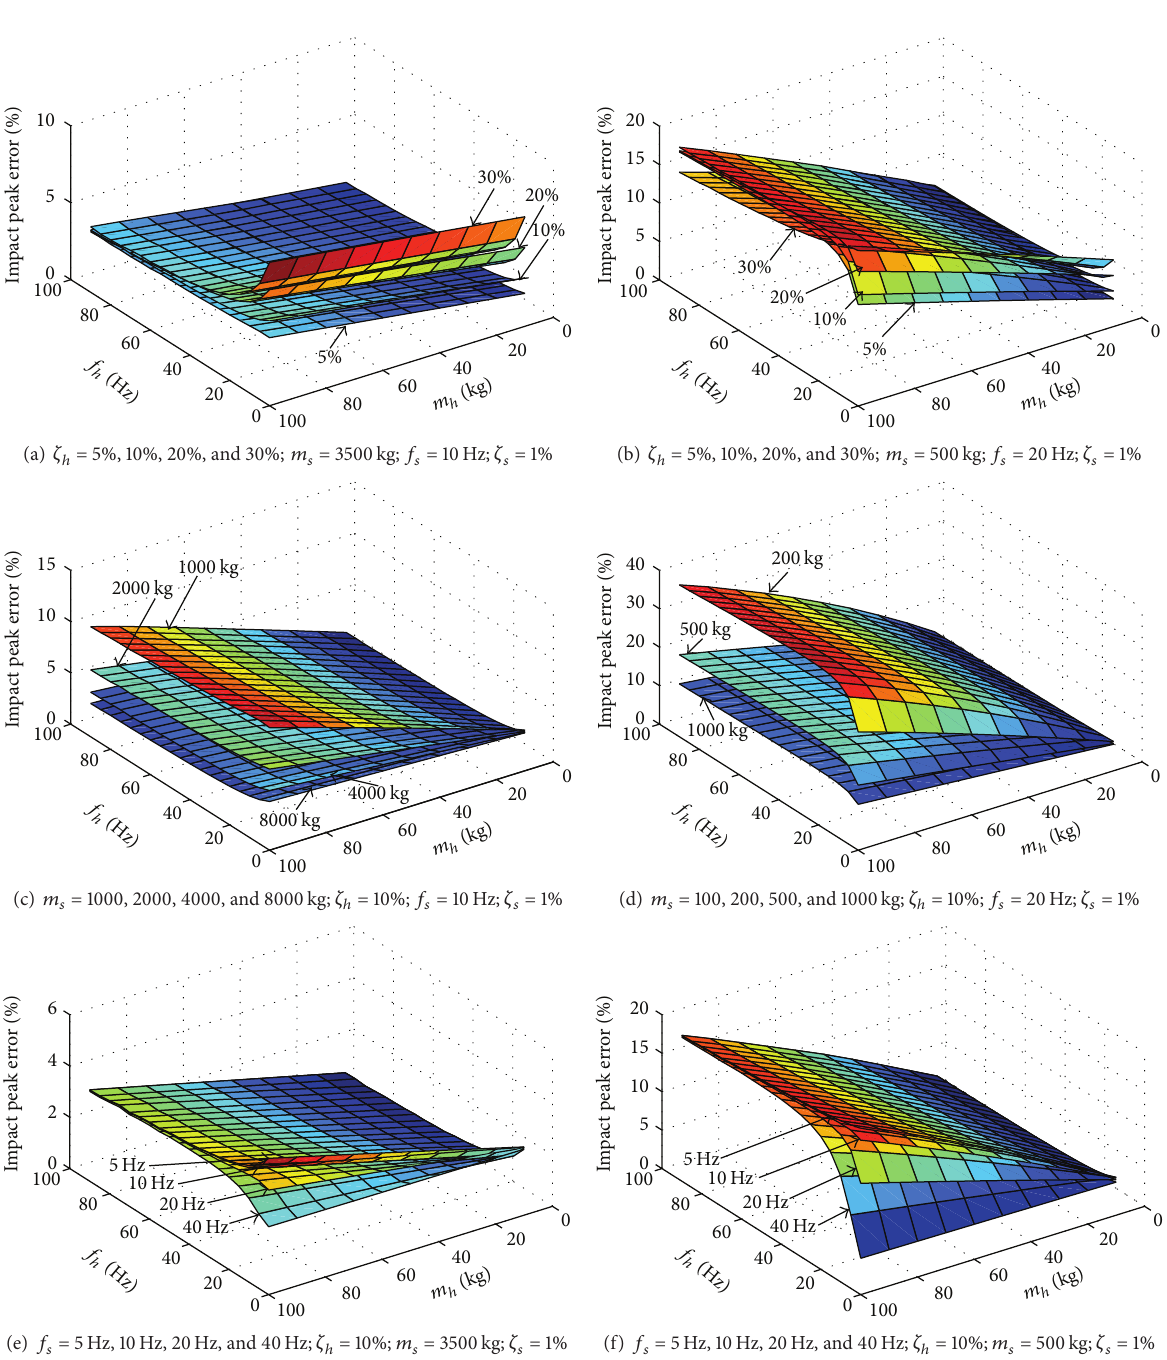
Figure 9: Effects of taking into account the floor dynamics on the peak impact force experienced by a human body: a typical building floor ((a), (c), and (e)) and a raised floor ((b), (d), and (f)).